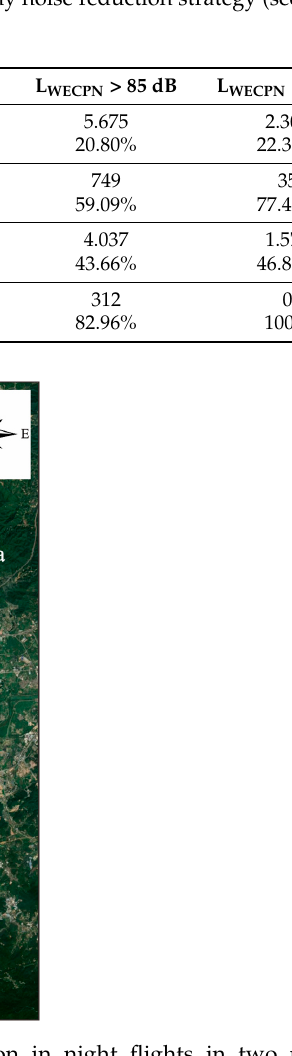
Figure 5. Proportions of the number of day, evening and night flights at BIA during ( a ) summer and ( b ) winter [28]. Table 3. Noise reduction effects by reducing the number of night flights in two stages during summer.